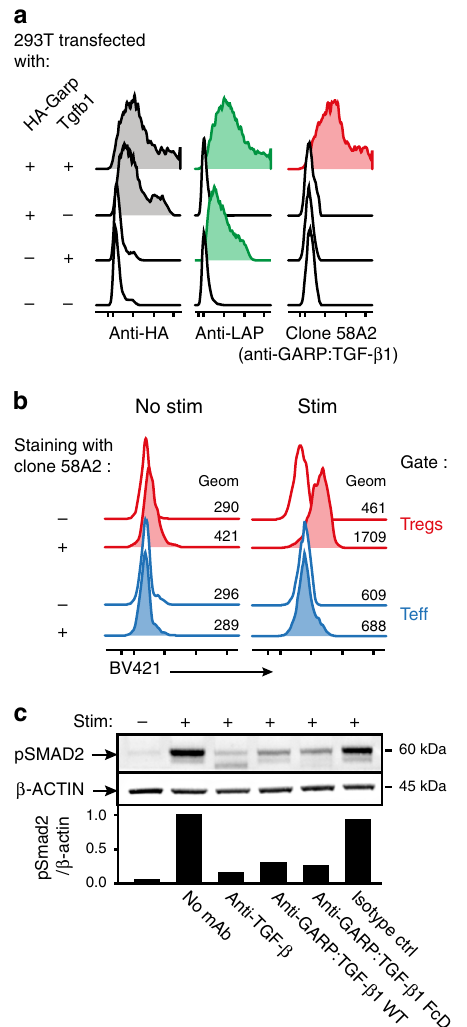
Fig. 1 An anti-GARP:TGF- β 1 mAb that blocks TGF- β 1 activation by mouse Tregs in vitro. a 293T cells were transfected with constructs encoding HA-tagged mouse GARP, mouse TGF- β 1 (i.e. LAP + mature TGF- β 1), or both, to induce surface expression of free GARP, free latent TGF- β 1, or GARP:TGF- β 1 complexes, respectively (Cuende et al. 21 ). Transfected cells were stained with the indicated antibodies and analyzed by fl ow cytometry. Histograms are gated on live cells. b Mouse splenocytes were stimulated (stim) or not with anti-CD3/CD28 coated beads during 24 h, then analyzed by fl ow cytometry after staining with anti-CD4 and anti-FOXP3 antibodies in the presence ( + ) or absence ( − ) of the biotinylated anti-GARP:TGF- β 1 clone 58A2, followed by streptavidin coupled to BV421. Histograms in red are gated on CD4 + FOXP3 + cells (Tregs), in blue on CD4 + Foxp3 - cells (Teff). c Magnetically-sorted CD25 + mouse splenocytes were stimulated during 24 h with anti-CD3/ CD28 coated beads in the presence or absence of blocking antibodies against active TGF- β (clone 1D11), GARP:TGF- β 1 complexes (clone 58A2, mIgG2a WT or FcD), or an isotype control (mIgG2a WT), then analyzed by Western blot with antibodies against β -ACTIN and pSMAD2, as a read-out for active TGF- β 1 production. Bar graphs on the bottom show quanti fi cation of ECL signals (ratio of pSMAD2/ β -ACTIN signals relative to that in cells stimulated in the absence of blocking mAb). Full scans are shown in Supplementary Fig.